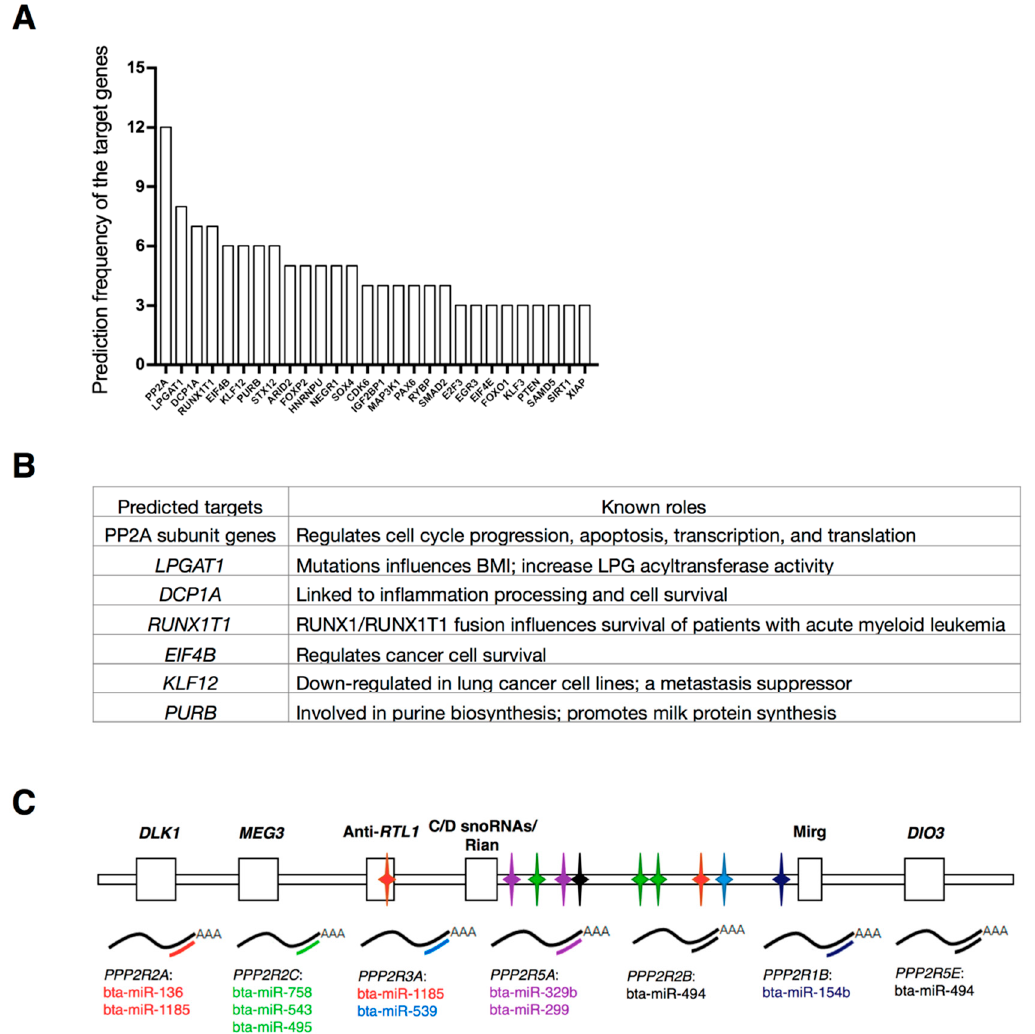
Figure 2. Identification of predicted target genes of the MEG3- iodothyronine deiodinase 3 (DIO3) miRNA cluster. ( A ) Prediction frequency of the genes potentially targeted by the miRNAs in the MEG3-DIO3 locus; ( B ) The top seven predicted targets of the MEG3-DIO3 miRNA cluster and their known roles in mammalian cells; ( C ) Target prediction diagrams of protein phosphatase 2A (PP2A) subunit genes by the MEG3-DIO3 miRNA cluster. A total of one scaffolding subunit gene and six regulatory subunit genes were predicted.